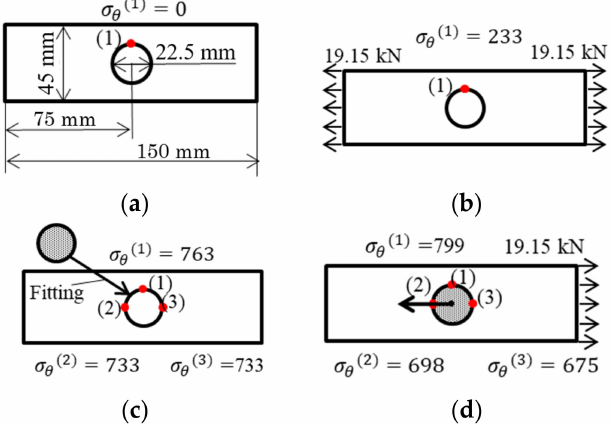
Figure 12. Stress estimation by 2D models [MPa]: ( a ) holed plate without load; ( b ) holed plate under tensile; ( c ) disk fitted without load; ( d ) disk fitted under tensile.